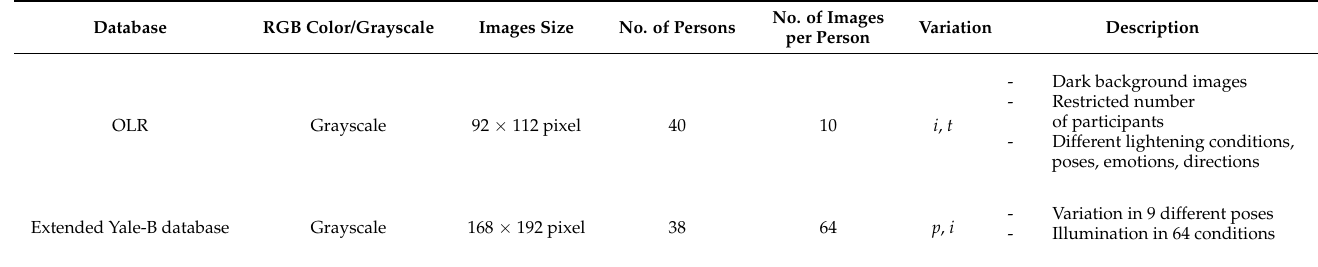
Table 1. Characteristics of databases used.